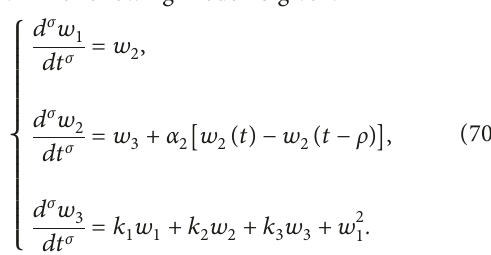
9 . 08 and the initial value is (1, 1, 1 . 9 0 (cid:25) 2 (cid:25) < 2 . 3511, and the bifurcation point ρ 0 . 77. We can ϑ 0 (cid:25) 0 (cid:25) easily check that the hypotheses of Theorem 1 are satisfied. Figure 6 indicates that when ρ 0 , 0 . 77 , the zero equi- [ ) librium point of model (70) is locally asymptotically stable. Figure 7 shows that when ρ 0 . 77 , , a Hopf ∈ [ + ) bifurcation happens for model (70). Both cases manifest ∈ ∞ by using the time-delayed feedback controller w t w t 2 . 2 ρ . 2 ( 2 ( [ ) − − )]